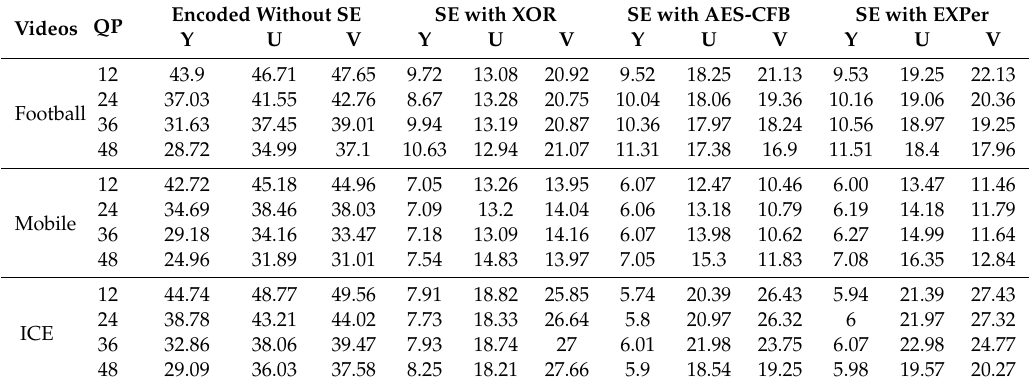
Table 7. Comparison of average PSNR (dB) of SE with XOR, AES-CFB and EXPer at four different QP levels.